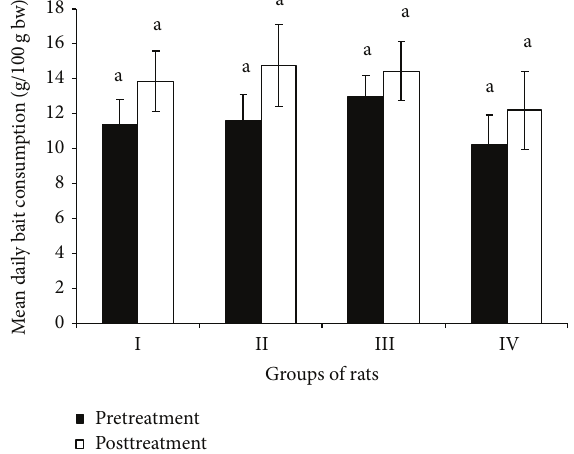
Figure 1: Mean daily consumption of WSO bait during pre- and posttreatment periods by different groups of